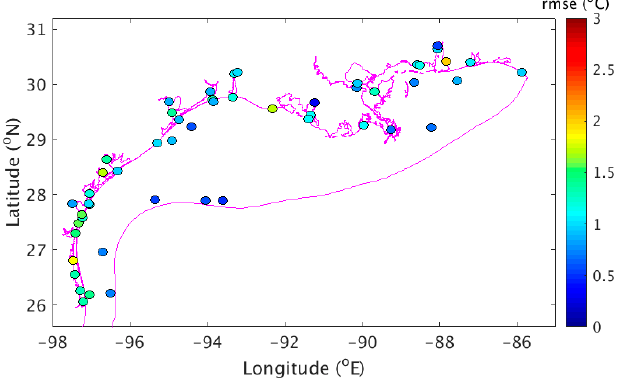
Figure 13. Color-coded RMSE of the modeled SST at 52 stations (Table A2).